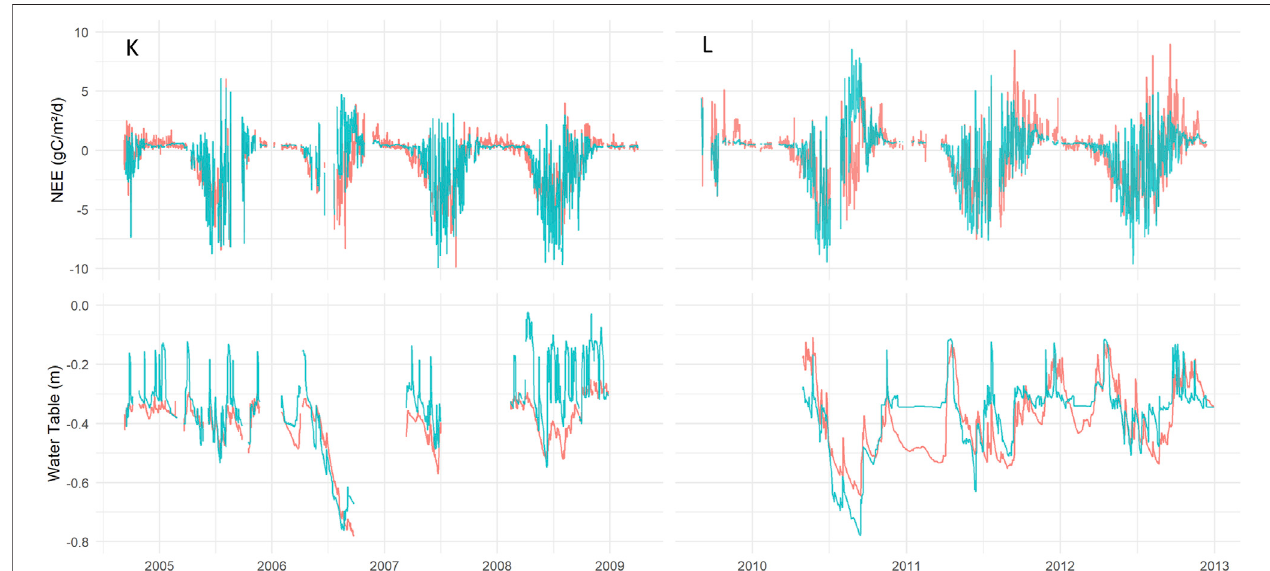
FIGURE 4 | Daily measured and simulated average NEE, g C m − 2 day − 1 and WT, m, expressed over the measurement period. On the left measured Kalevansuo data (red) together with simulated K (blue-green). On the right the same for Lettosuo and L data.